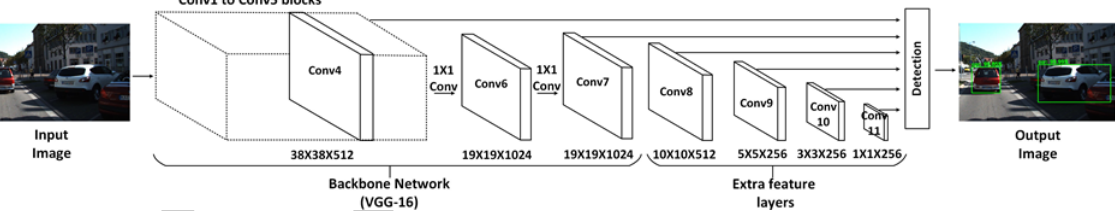
Figure 4. The architecture of the Single Shot Multi-Box Detector (SSD) [28]. RetinaNet